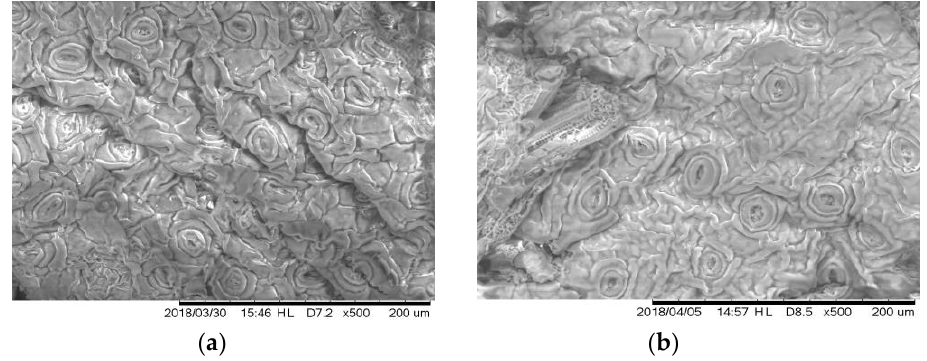
Figure 8. Scanning electron micrographs of ( a ) C6-AGT and ( b ) C8-AGT.